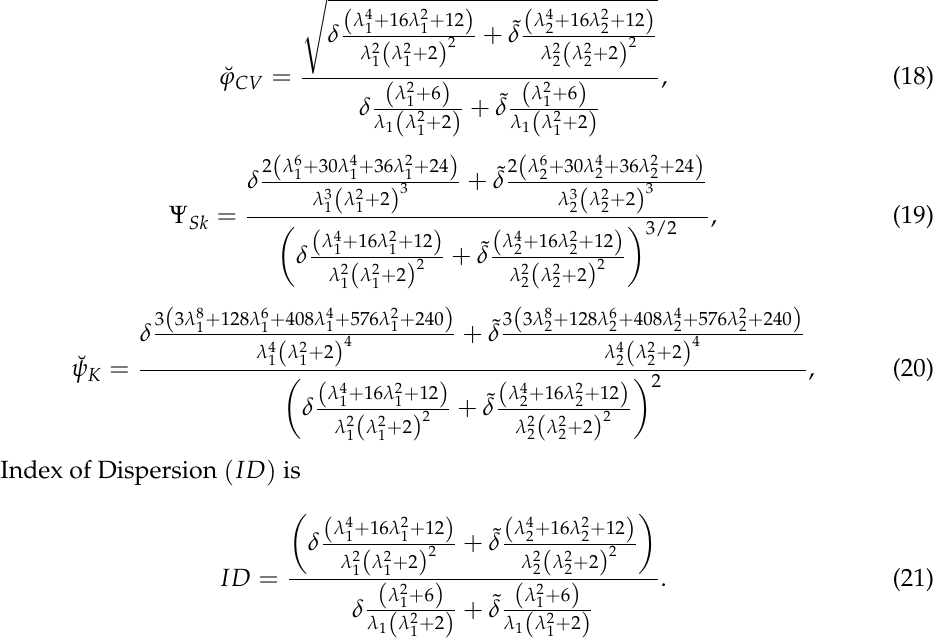
Fig. 6. Variations of Coe¢ cient of Skewness SK , of TC-MAM ( $ ) . Fig. 7. Behaviour of Coe¢ cient of Kurtosis ( K ) of TC-MAM ( $ ) . Graphs of the ID of TC-MAM ( $ ) for various parameter settings are illustrated in Fig. 5. The boosting attitude of (cid:14) rise the concentration of mean for the all varying values of (cid:21) 2 (see Fig. 5a). Whereas boosting attitude of (cid:14) reduce the the concentration of mean for the all varying values of (cid:21) 1 (see Fig. 5b). The e⁄ects of (cid:14) against the concentration of the mean pro(cid:133)le are shown in Fig.5c. The concentration of the mean pro(cid:133)le is a decreasing function 9